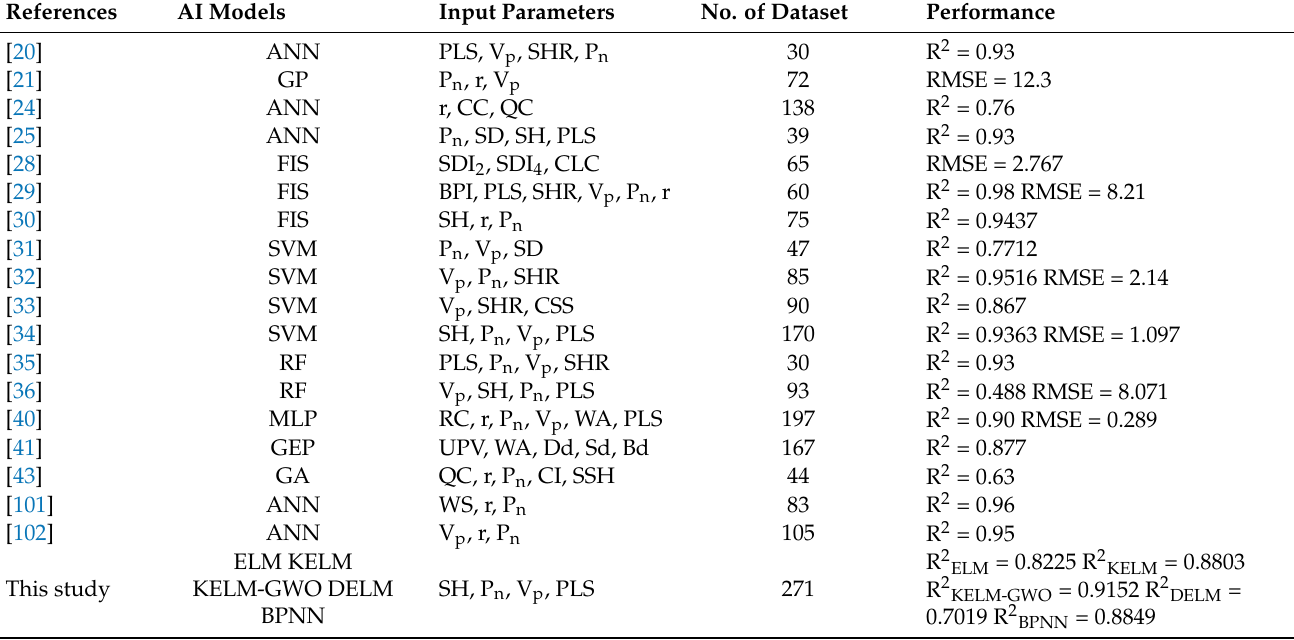
Table 6. Comparison between the current and previous works by using AI algorithms for UCS of rock prediction.